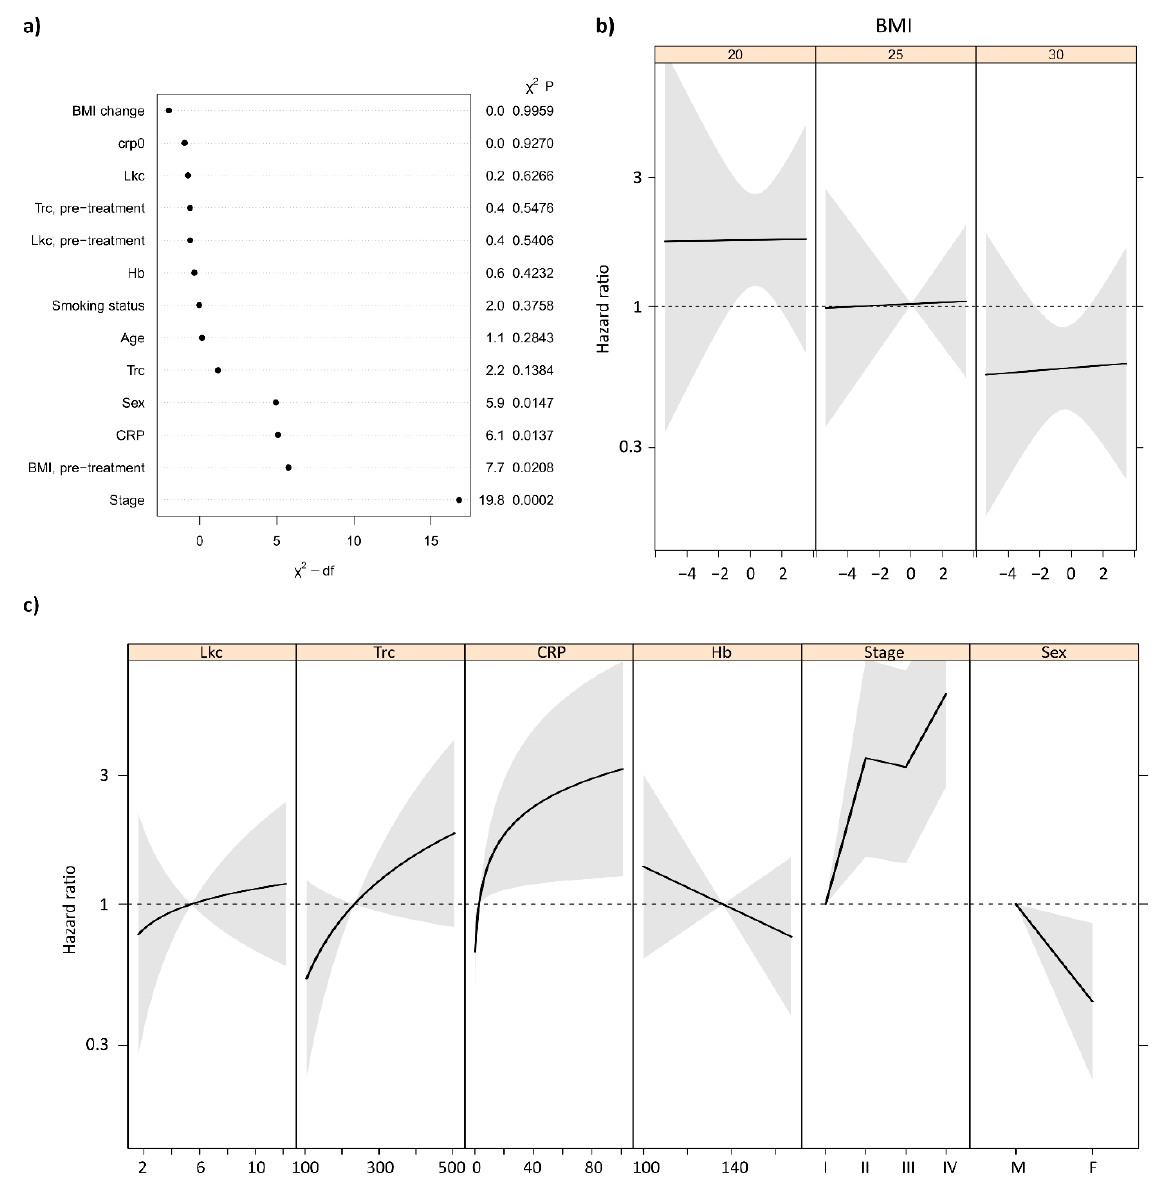
Figure 1. ( a ) Individual contribution to the model fit from each factor in the full Cox regression model, as tested by the Wald test. ( b ) Hazard ratios of BMI change for different categories of initial BMI. No significant differences were seen. A hazard ratio of 1 indicates no change from baseline. ( c ) Hazard ratios for the examined factors in the adjusted Cox proportional hazards model relative to the median value for each factor. For CRP there was a significant correlation between high CRP counts and increased risk of recurrence, while for Trc, Hb, and Lkc the correlation was not signifi- cant.